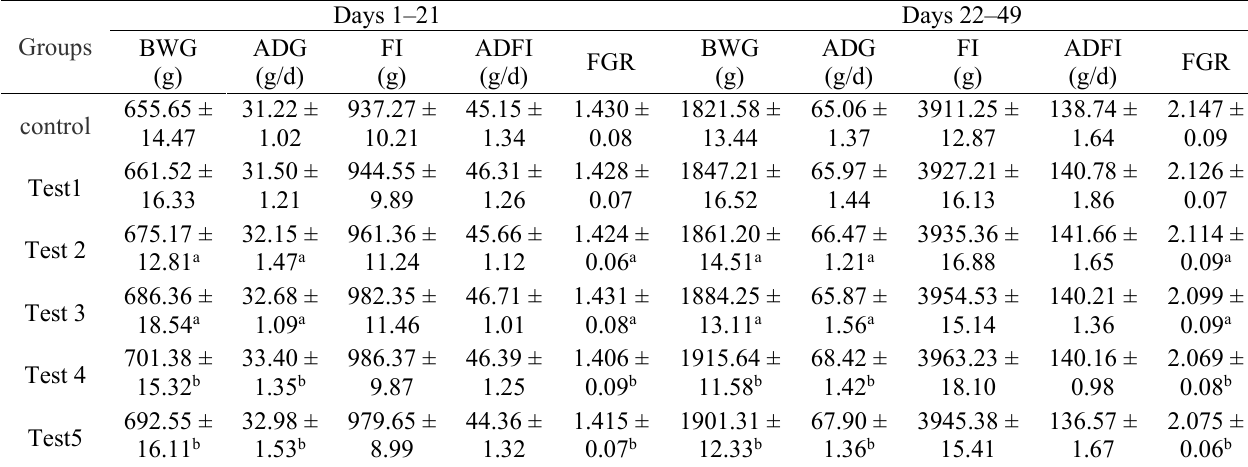
Table 2 Effects of CB on performance of broilers (n = 6)